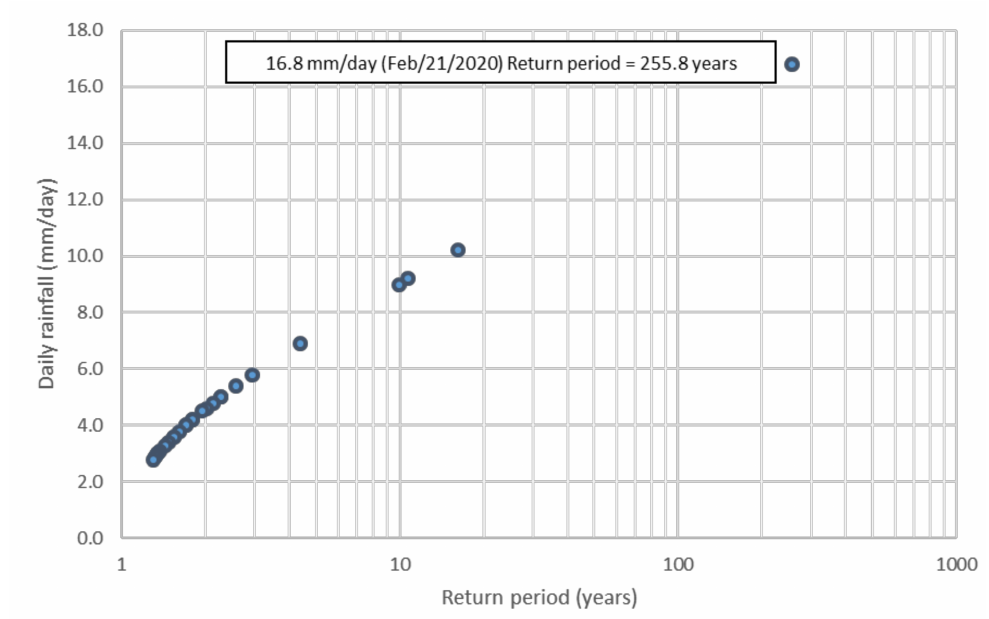
Figure 3. Frequency analysis of the partial series of total daily precipitation at JORGE BASADRE rain gauge (from 1993 to 2020).